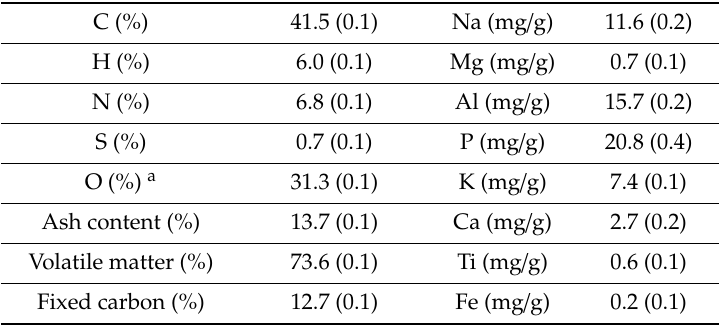
Table 1. Composition on a dry basis of the dewatered waste activated